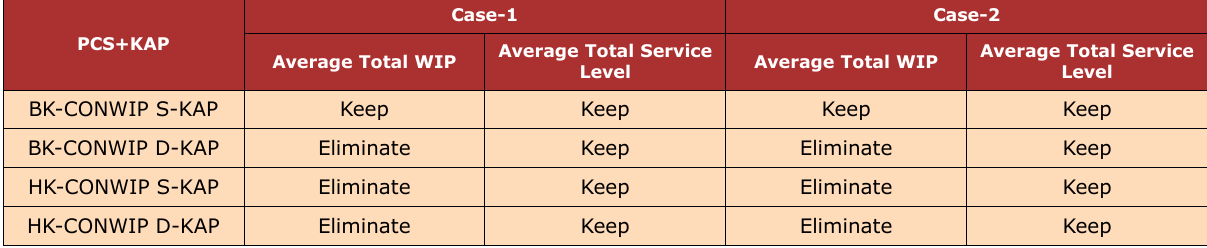
Table 12. Summary from application of Nelson’s combined procedure for selection of best